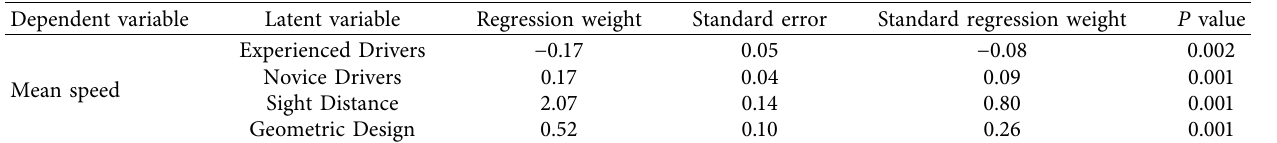
Table 15: SEM results for the latent